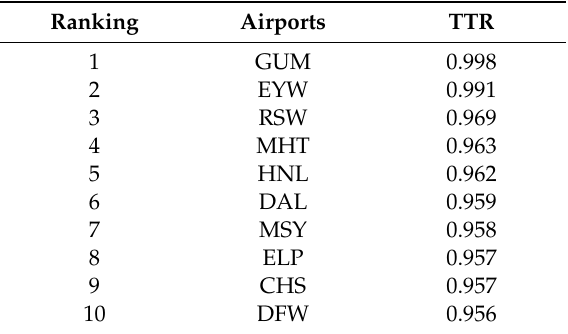
Table 5. The top 10 Airports for travel-time reliability.